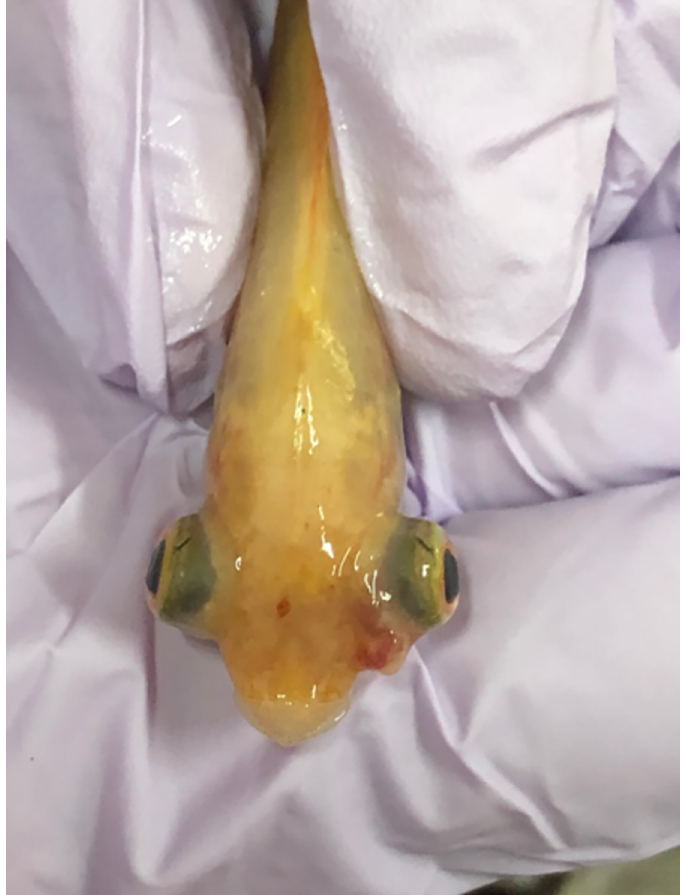
Fig 7. Bilateral exophthalmia of the eye (pop-eyes) and eye hemorrhages (left eye) were found in moribund fish with Streptococcus agalactiae